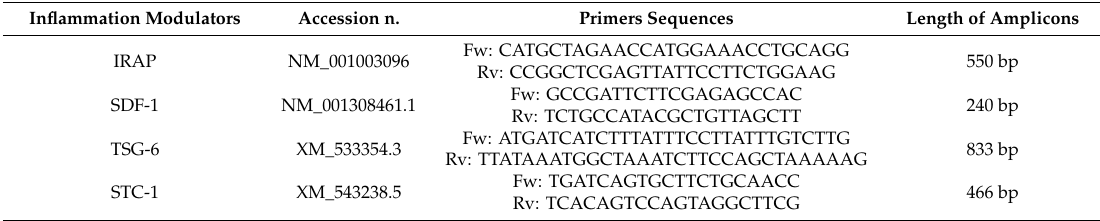
Table A2. Primers used to verify the expression of “inflammation modulators” in canine ADMSCs and SVF